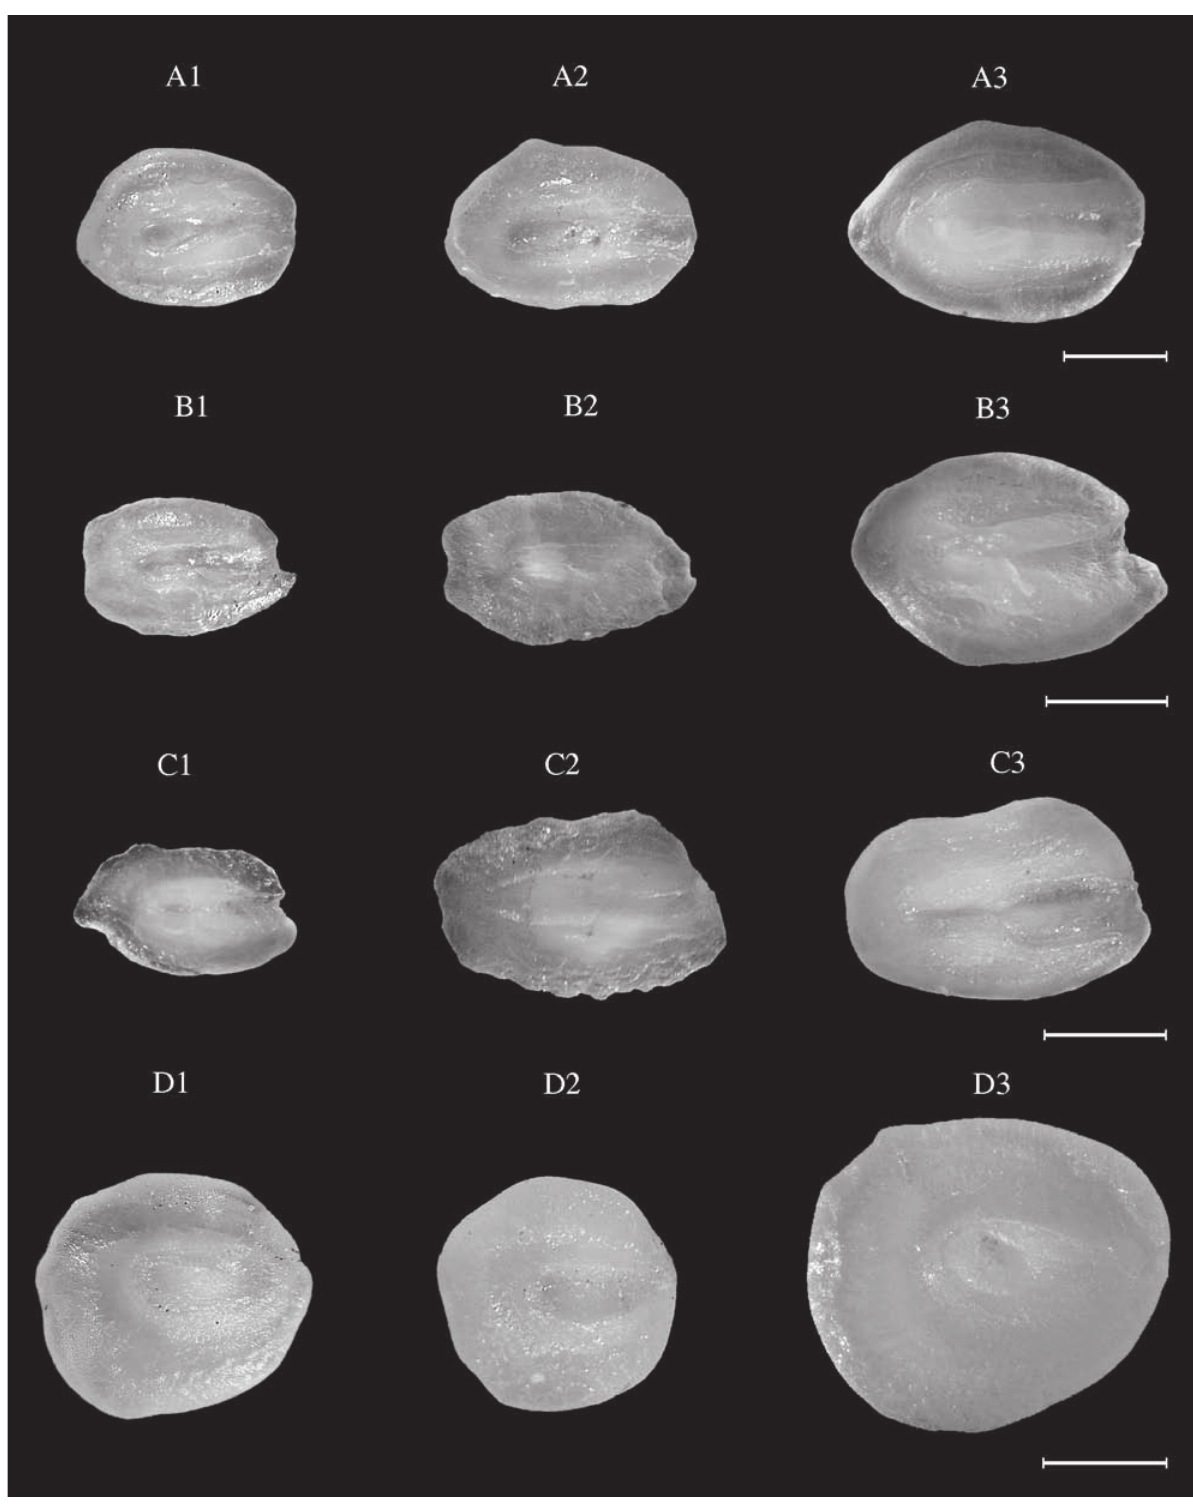
Fig. 90. – Arnoglossus rueppelii. TL: A1, 10.0 cm (WM); A2, 10.5 cm (WM); A3, 11.0 cm (NEA). Arnoglossus thori. TL: B1, 8.0 cm (WM); B2, 9.6 cm (NEA); B3, 12.6 cm (NEA). Bothus podas. TL: C1, 9.5 cm (NEA); C2, 13.2 cm (CEA); C3, 17.5 cm (WM). Bathysolea profundicola. TL: D1, 10.0 cm (WM); D2, 11.5 cm (WM); D3, 17.4 cm (NEA). Scale bar = 1